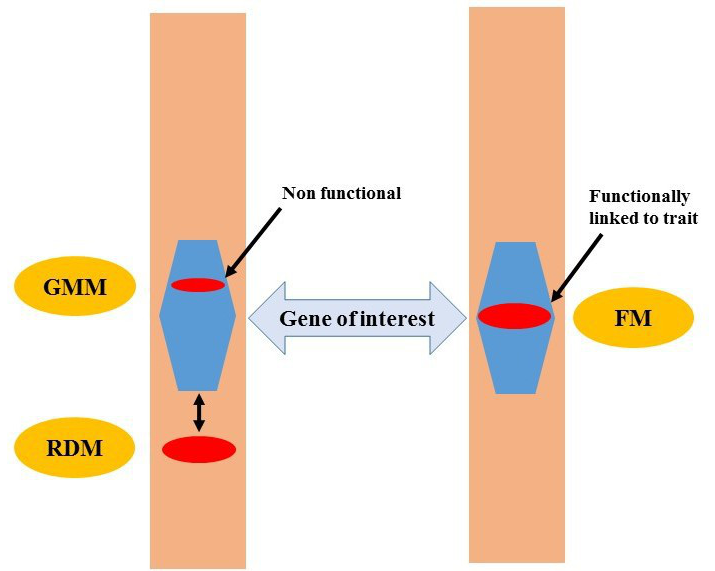
Figure 1. Functional markers (FMs) are functionally linked with phenotypic traits compared to random DNA markers (RDMs) and genic molecular markers (GMMs).